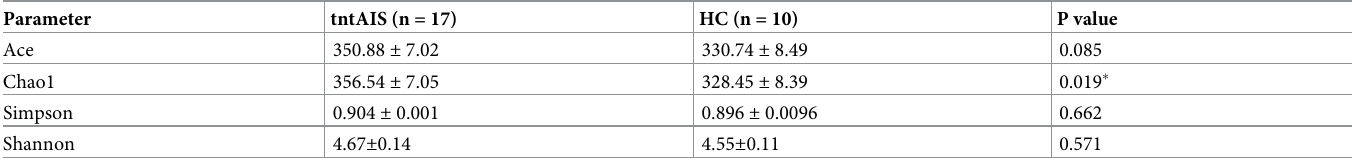
Table 3. Analysis of the α -diversity between the tntAIS and HC